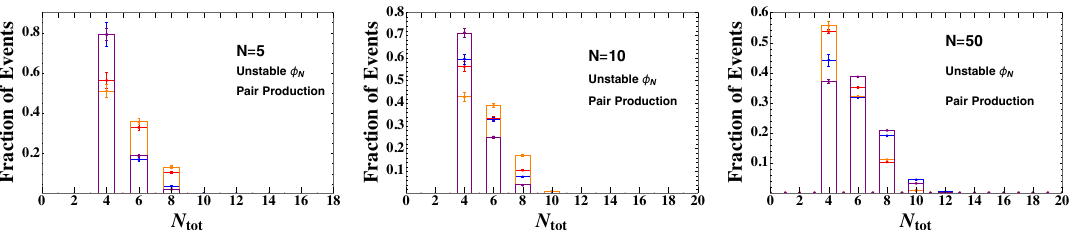
Figure 10. Total number of particles in the event in the scenario where all couplings in eqs. (3.1) and (3.2) are present and pair production dominates. Di(cid:11)erent colors correspond to di(cid:11)erent spec- tra. From left to right: N =5, 10, and 50 scalars in the new sector.